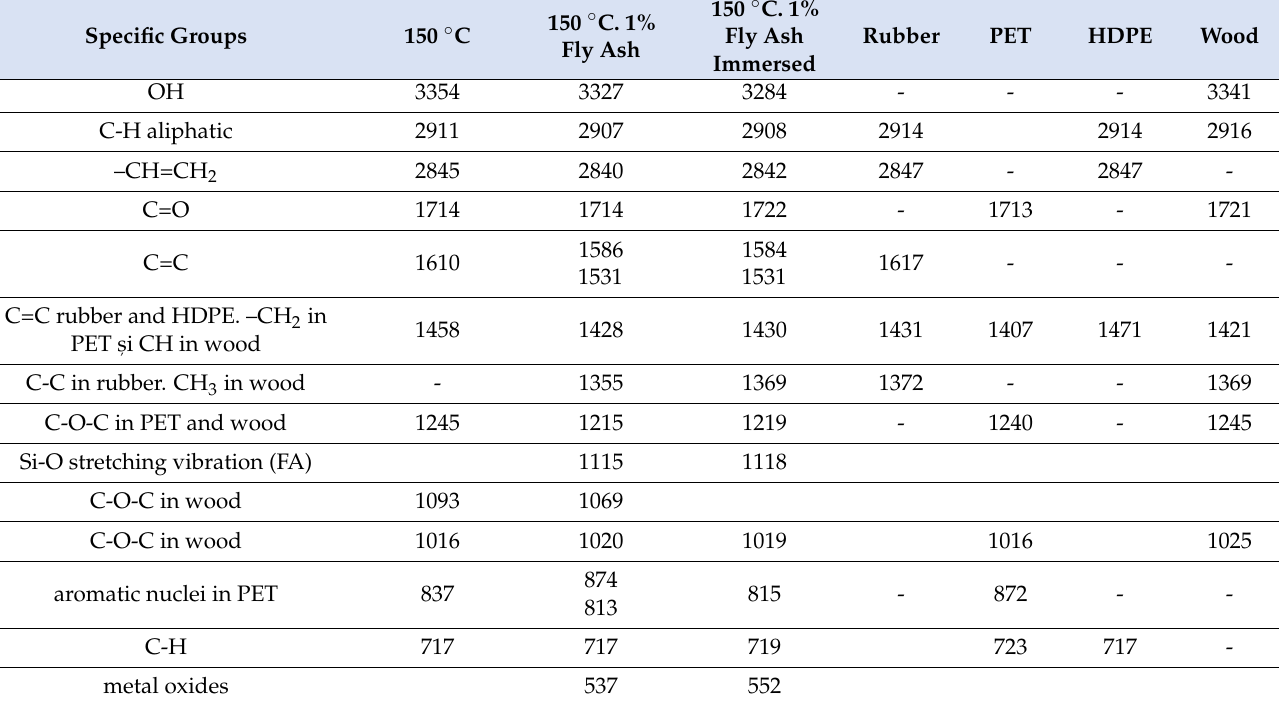
Table 5. Representative band values in the IR spectra of water-immersed fly ash